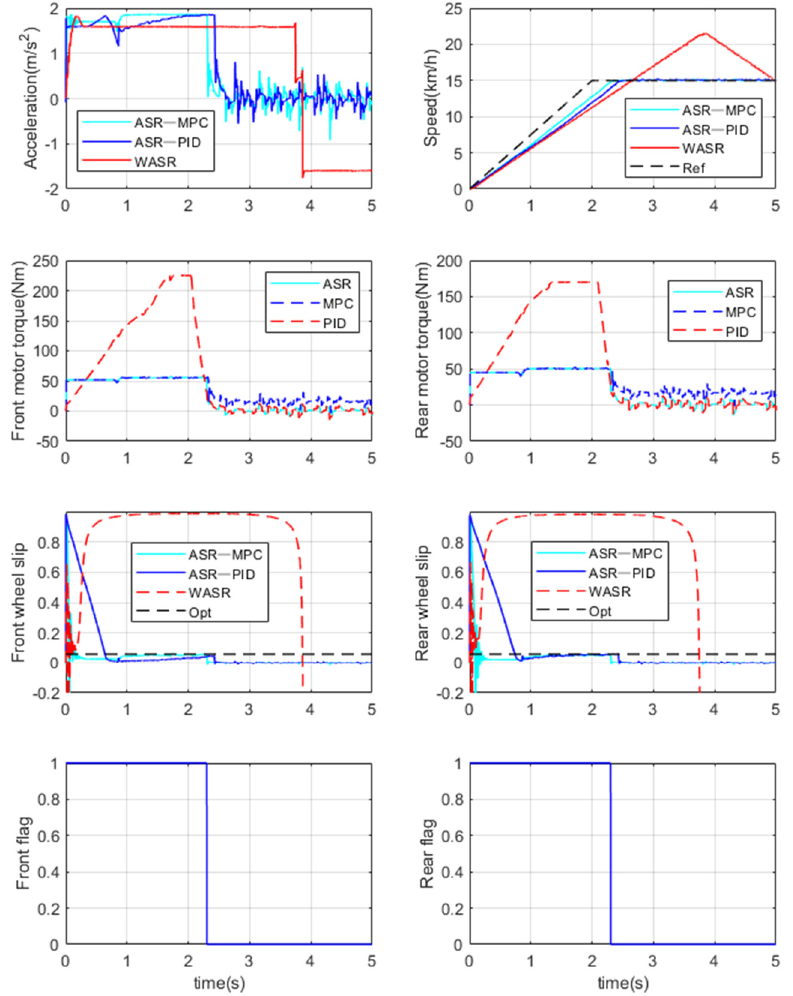
Figure 6. Vehicle starts under a low adhesion coefficient road.